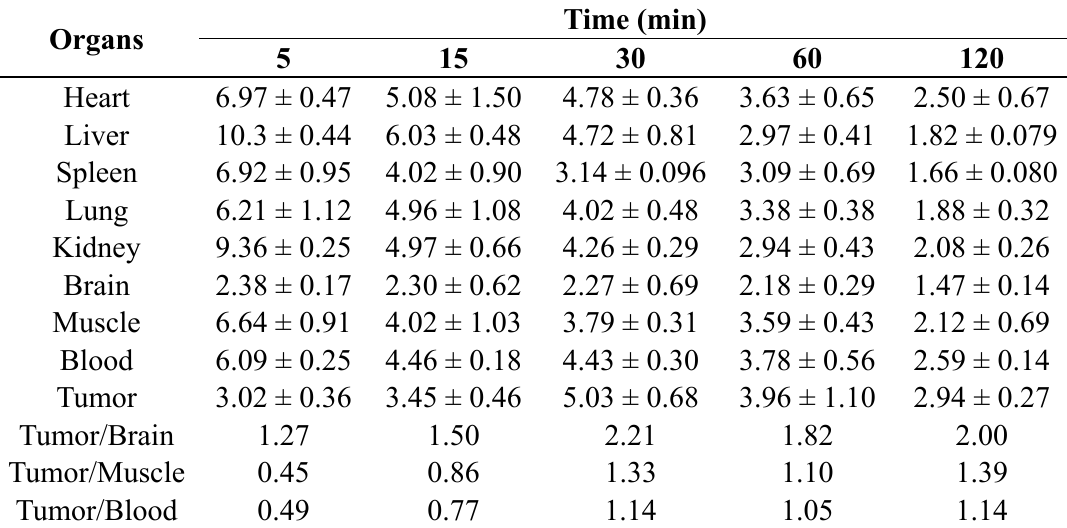
Table 1. Biodistribution of [ 18 F] 3 in mice bearing S 180 tumor. Expressed as % injected dose per gram (% ID/g ± SD), n =